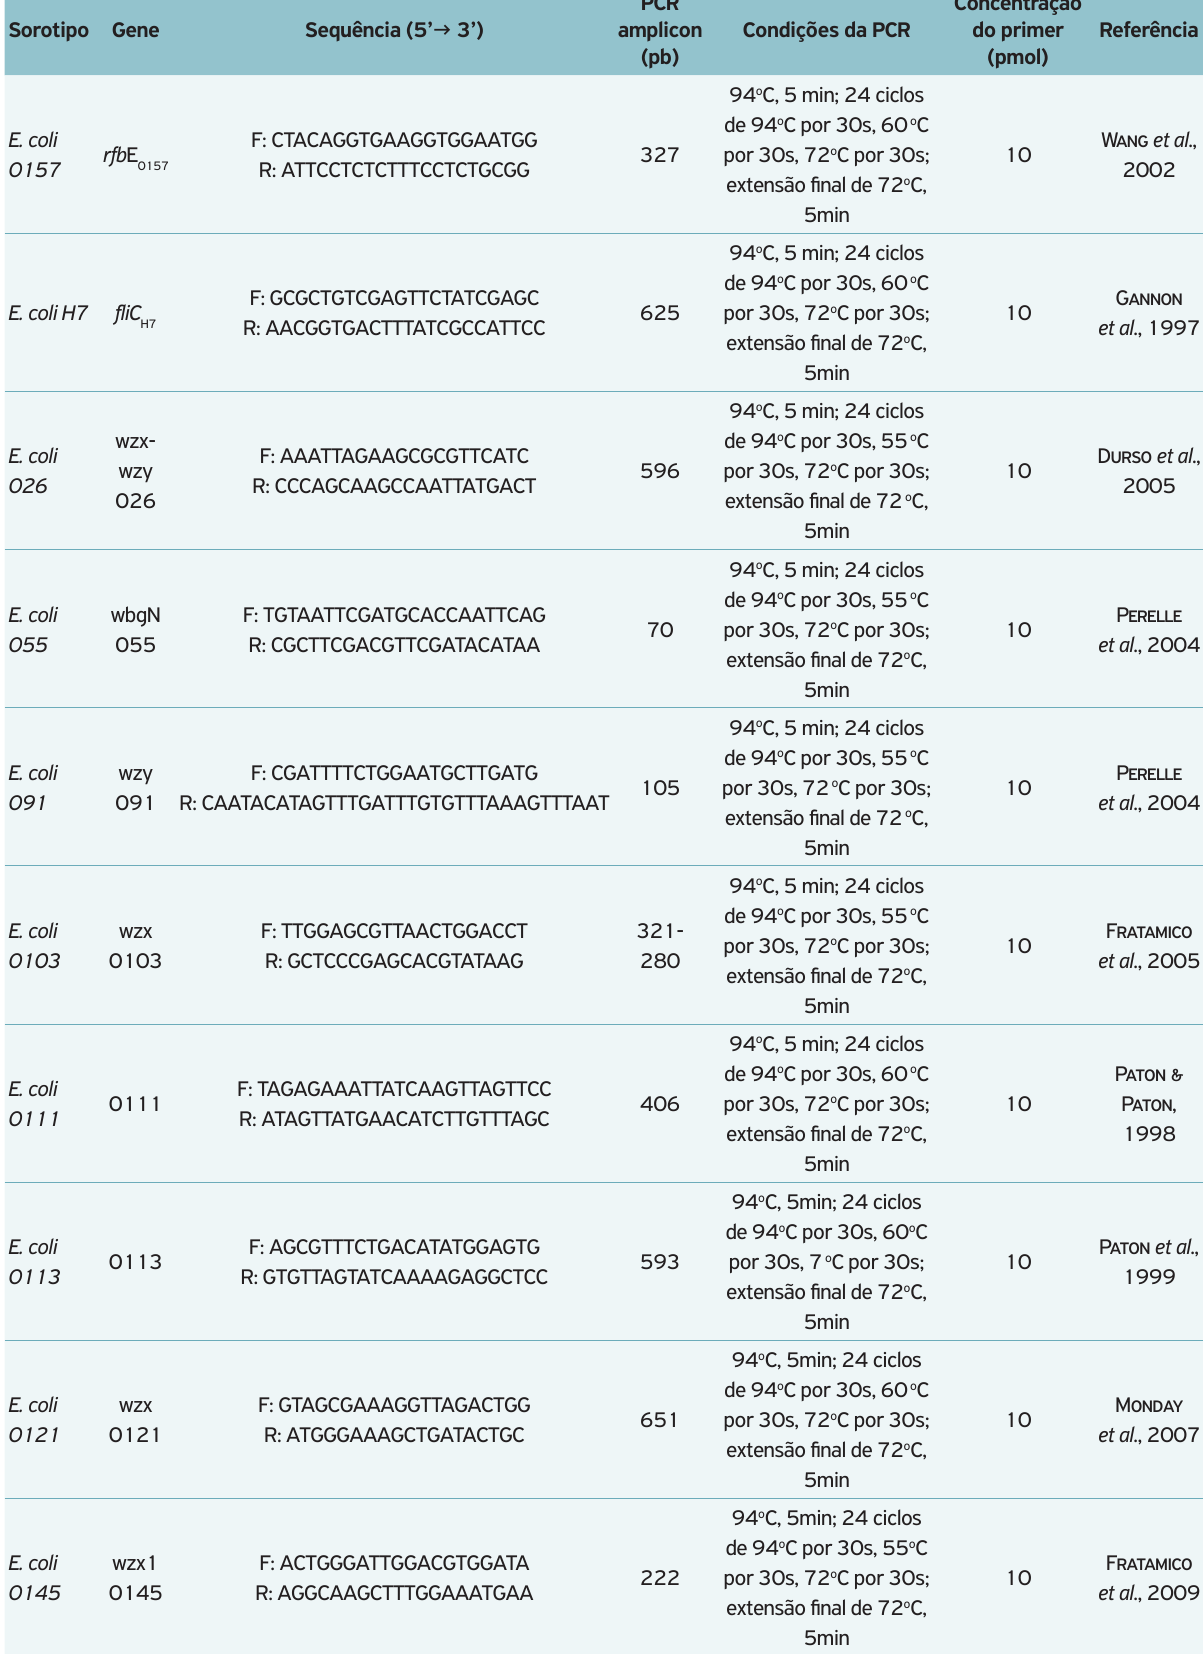
Tabela 1. Características dos primers utilizados na